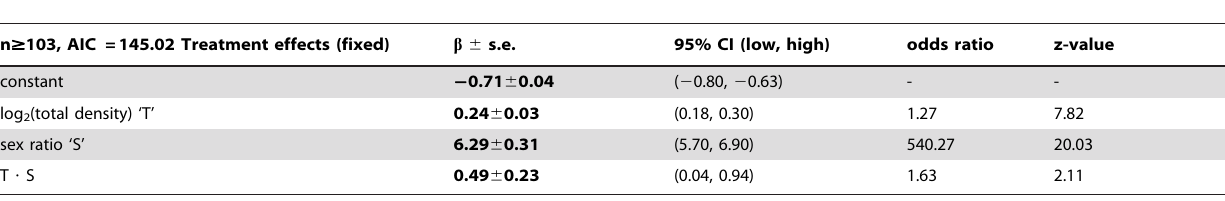
Table 2. Results of the (logistic) regression model of the ln-transformed odds of fertilization for female Drosophila (fruit flies) in the experiment of Wallace [3] {